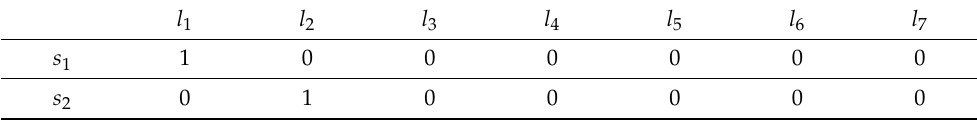
Table 3. Sources-links incidence matrix, I S , for the illustrative example.